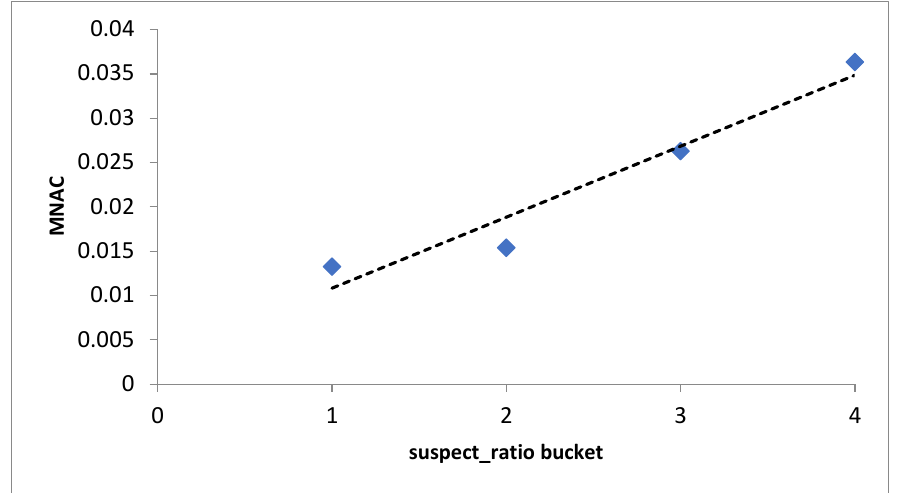
Figure 1. Trend of mean normalized audit count (MNAC) across the suspect ratio